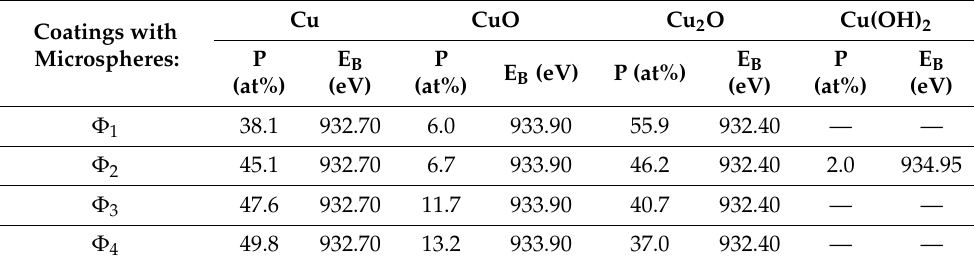
Figure 9. XPS spectra of laser irradiated (N = 500; Ej = 100 mJ/cm 2 ) of coatings containing microspheres: ( a ) Φ 1, ( b ) Φ 2 , ( c ) Φ 1 and ( d ) Φ 1 . Table 3. Relative percentage (P) of individual forms of copper on the surface of coatings with glass microspheres after irradiation with laser